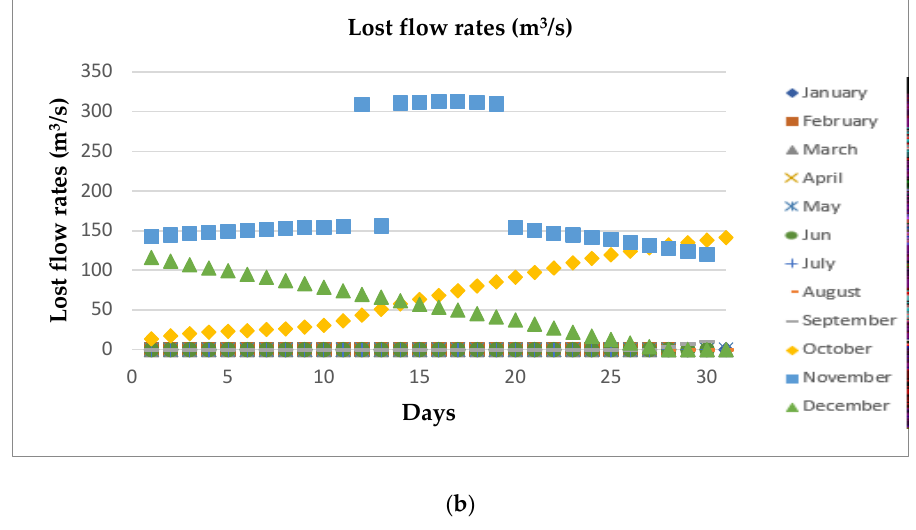
Figure 13. ( a ) Average monthly lost flow rates histogram and ( b ) average daily lost flow rates curve.